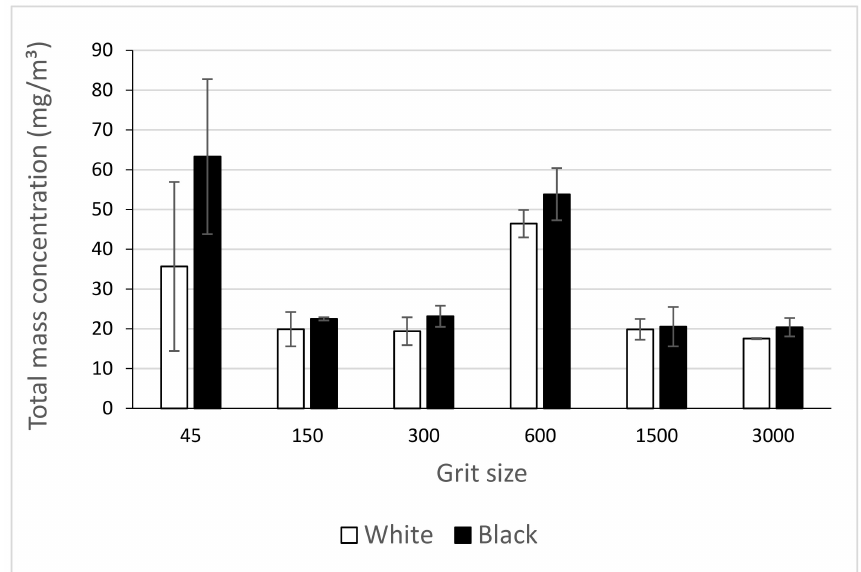
Figure 8. Total mass concentration of FP while grinding white and black granite for different grit sizes (Vs = 3500 rpm; f = 1000 mm/min).